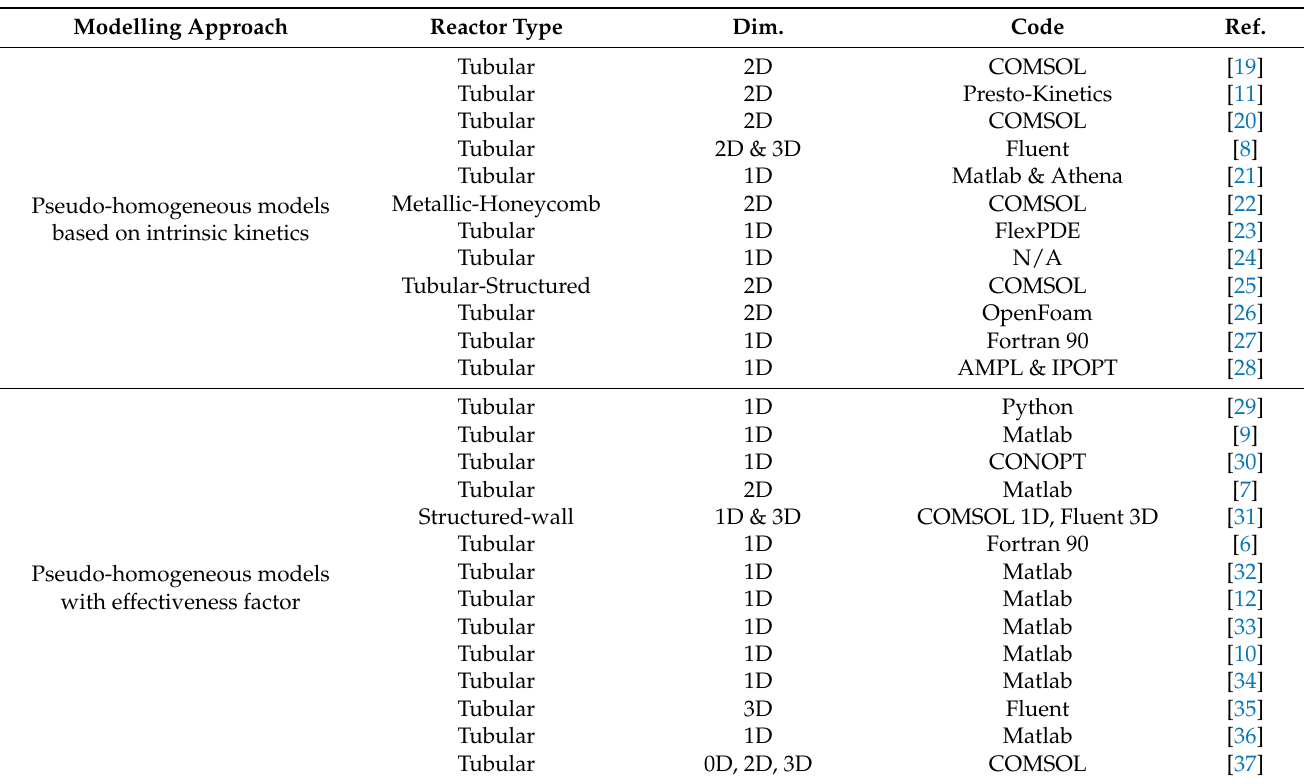
Table 1. Summary of published fixed bed methanation